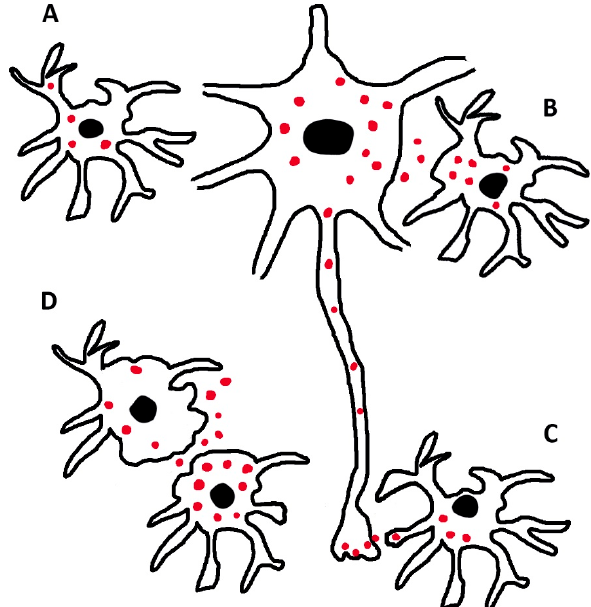
Figure 3. Distribution and dynamics of phosphorylated tau in astrocytes and neurons. In ( A ), an astrocyte contains intracellular tau (red dots) possibly generated locally. In B and C, a neuron interacts directly with astrocytes, exchanging tau at its body ( B ) and its synaptic ( C ) level. ( D ) shows two astrocytes with tau distributed in their cytosol and in their extracellular space. The interaction of these glial cells with a neuron is not excluded. This could occur primarily at a distance.